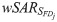
Risk of screening adherence by category of FD practices.A. FDs wSARSFDj (the markers correspond to the practice baricenter and marker colors to adherence category) plotted against SARs for small triangular areas (about 0.50 km2). B. Top panel: crude adherence rates (left) and wSARSFDj (right) by FD practices. Bottom panel: marginal predicted adherence probability for low adherence FDs and high participation FDs and, for comparison, adherence probability for a generic person at average level of covariates. Figure was created by the author Bianconi F. combing the caterpillar, bar plots and maps generate with GeCO-sys an extension of [21].